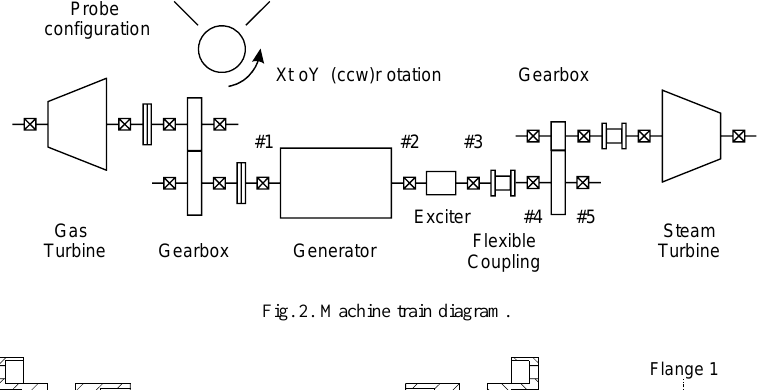
Fig. 2. Machine train diagram.